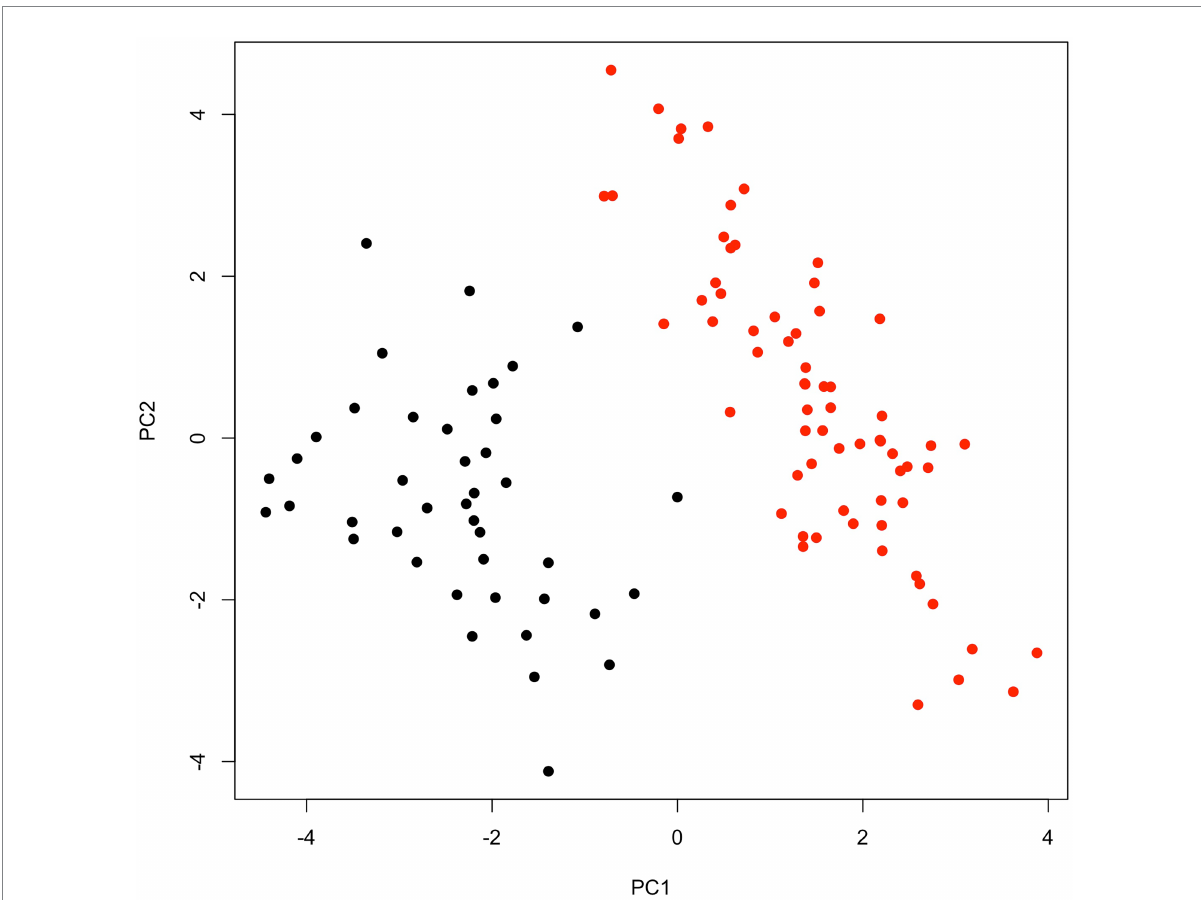
FIGURE 2 Phenotypic differentiation for early- and late-flowering pearl millet accessions. Mean phenotypic measures across nine repetitions for 11 traits of 109 accessions were used to perform PCA. PC1, and PC2 explained 41.5 and 28% of the inertia, respectively. Early- (red) and late-flowering (black) accessions are well separate on the first PCA